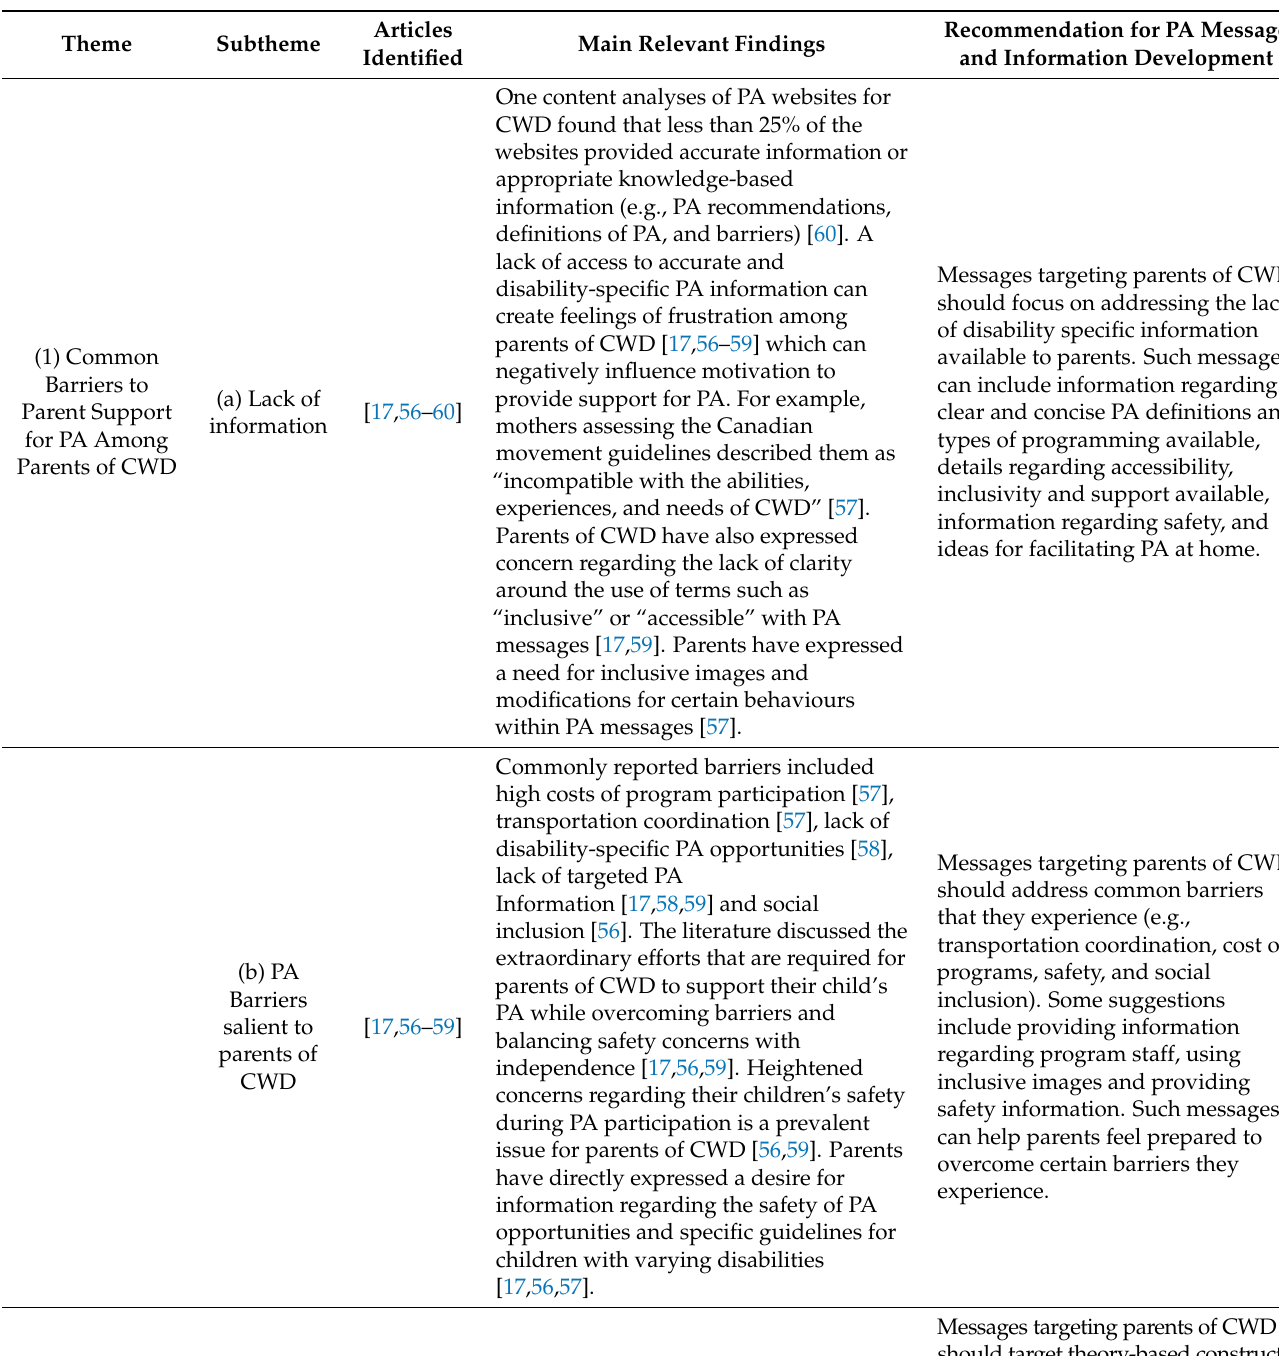
Table 4. Literature regarding the development of physical activity messages targeting parents of children with